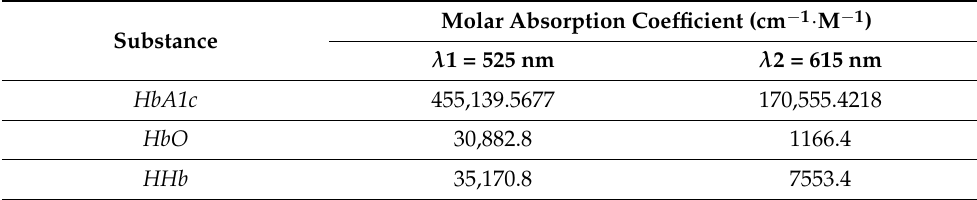
Table 1. Molar absorption coefficients for the blood vessel